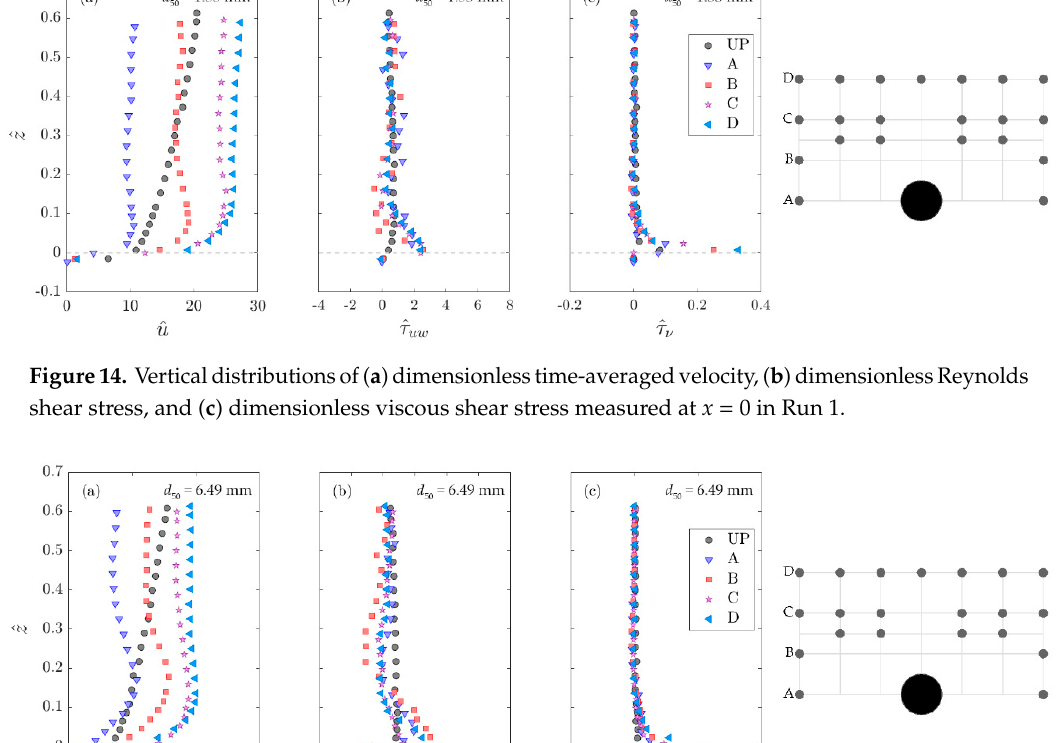
Figure 13. Vertical distributions of ( a ) dimensionless time-averaged velocity, ( b ) dimensionless Reynolds shear stress, and ( c ) dimensionless viscous shear stress measured at y = 0.5 B s in Run 3.